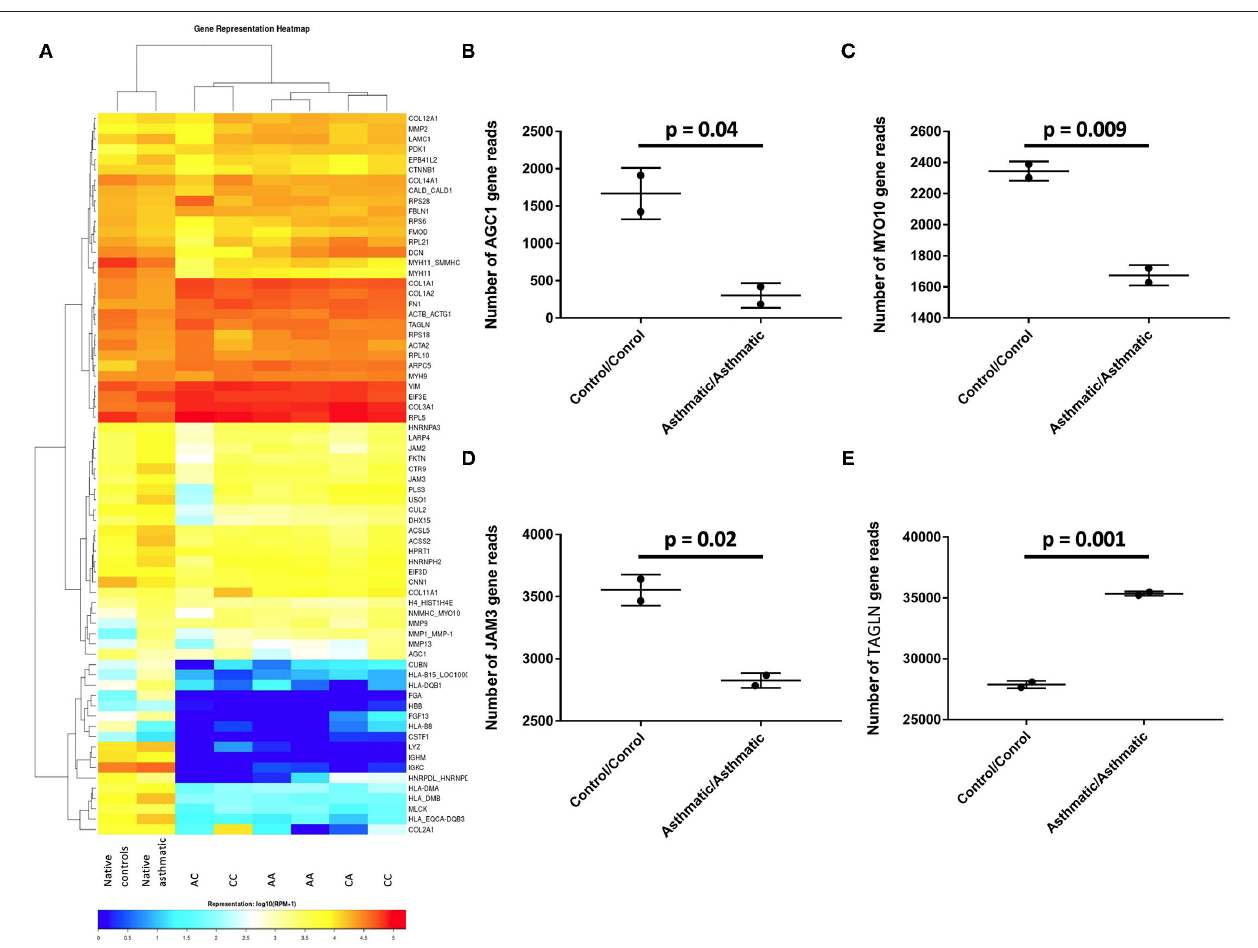
FIGURE 5 | Differentially expressed genes in the control cell/control matrix group vs. the asthmatic cell/asthmatic matrix group. (A) Heatmap of all the analyzed groups with CC representing the control matrix/control cell group; CA is the control matrix/asthmatic cell group; AC is the asthmatic matrix/control cell group; AA is the asthmatic matrix/ asthmatic cell group. (B) AGC1 , (C) MYO10, and (D) JAM3 were significantly upregulated in the control/control group, while (E) TAGLN was overexpressed in the asthmatic /asthmatic